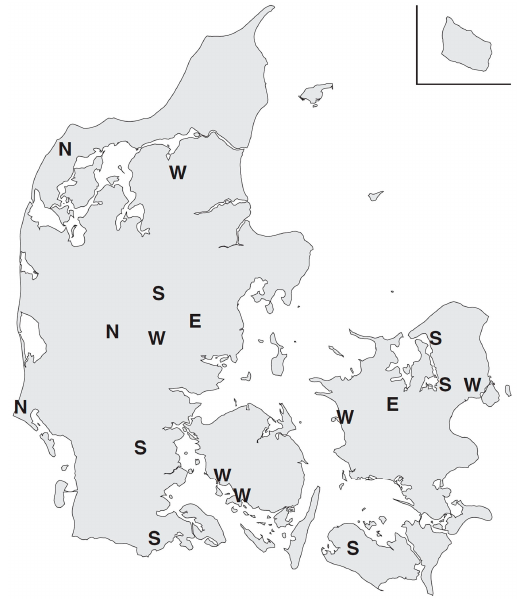
Figure A1. Map of Denmark and the location of the study lakes. Smaller panel at the upper-right corner shows Bornholm. S, W, N denote lake types (strong, weak and no TP decrease) and E denotes lakes not included in any of the groups.